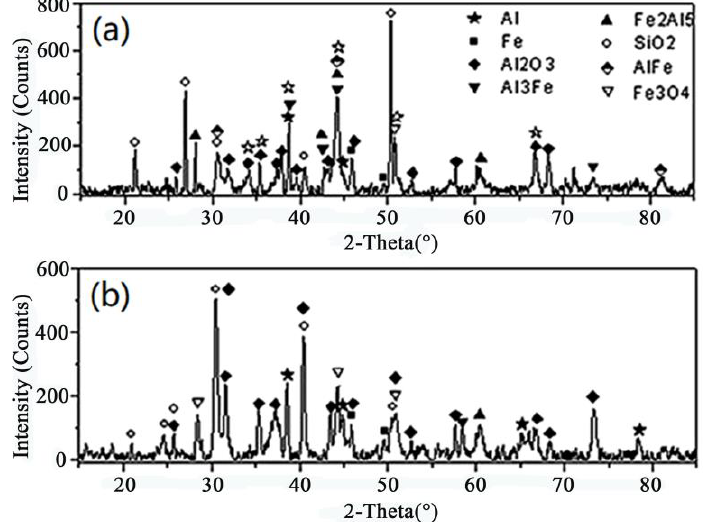
Figure 19. XRD patterns of the reaction products with di ff erent thickness targets: ( a ) 2 mm target and ( b ) 5 mm